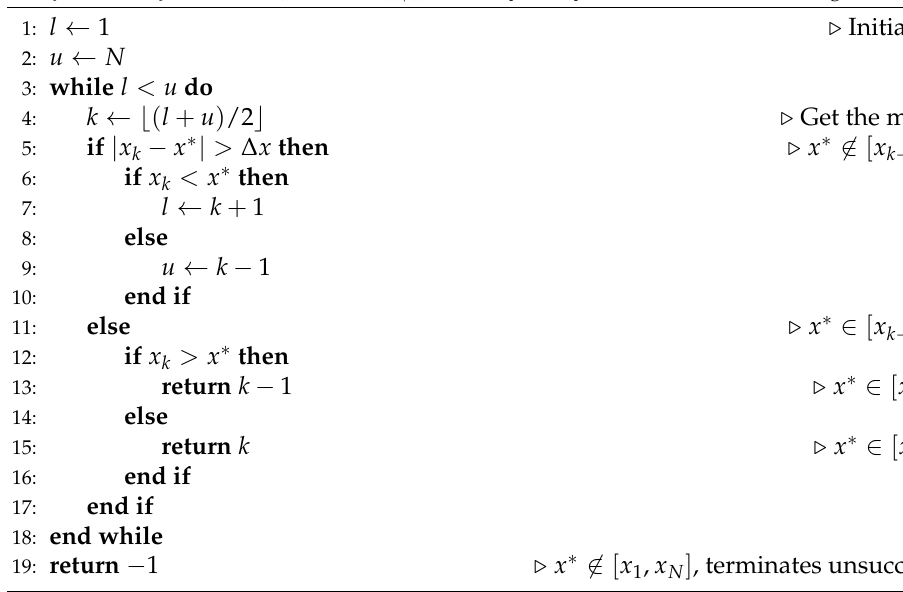
Algorithm 1. Modified binary search: given a sequence of ordered values x 1 < x 2 < · · · < x N with regular spacing ∆ x (i.e., fulfilling (4)) and a value x ∗ ∈ R , the modified binary search finds the index k ∈ { 1,2, . . . , N } such that x k ≤ x ∗ ≤ x k + 1 . If x ∗ (cid:54)∈ [ x 1 , x N ] , it returns − 1, terminating